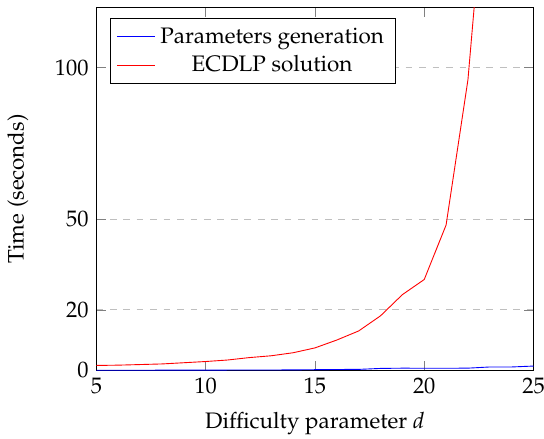
Figure 4. Time comparison between parameters creation and ECDLP